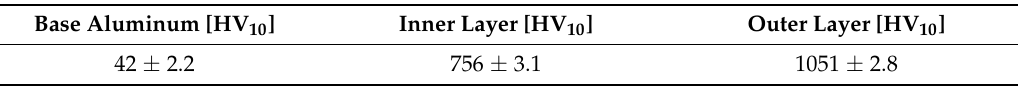
Table 2. Micro-hardness test results of different alloy coating depth related to Figure 6: Base metal: point 4; inner layer: point 3; outer layer: point 2.